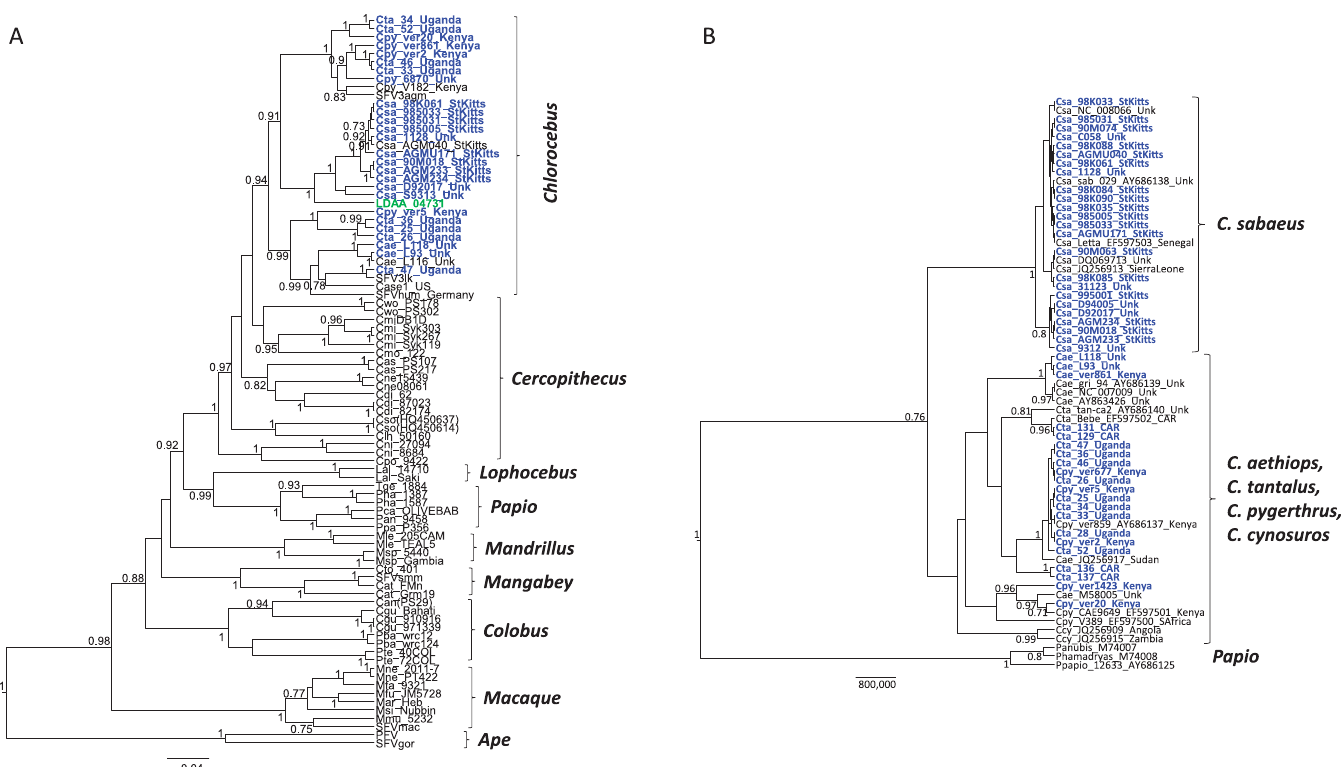
Fig 3. Inference of the evolutionary history of human infection with simian foamy virus (SFV). A . Bayesian SFV polymerase ( pol) maximum clade credibility tree inferred using an alignment of 375-bp and 88 Old World monkey and ape taxa, including 26 new African green monkey sequences (in blue text). The SFV pol sequence from the Côte d ’ Ivoire patient, LDAA-04731, is shown in green text. B . Chlorocebus mitochondrial DNA phylogenetic relationships inferred by Bayesian analysis of an alignment of 496-bp from 65 taxa. New sequences generated in our study are highlighted in blue text. Animal country of origin given at end of taxa names; CAR = Central African Republic, Unk = provenance unknown. Csa, Chl . sabaeus , Cae, Chl . aethiops , Cta, Chl . tantalus , Cpy, Chl . pygerythrus , Ccy, Chl . cynosuros . Posterior probabilities > 0.7 are given at major nodes in the tree. Scale bar is in units of time.